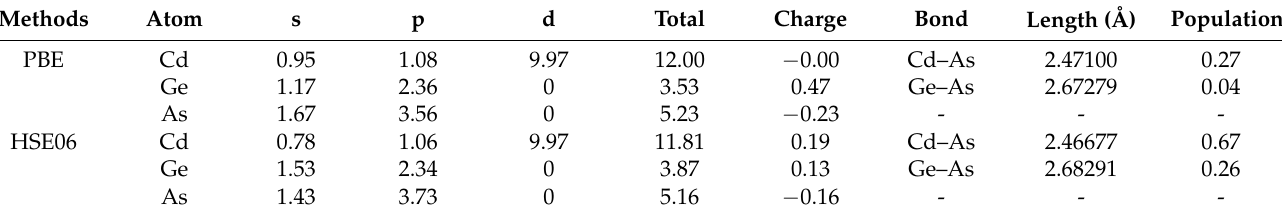
Table 4. The population analysis of CdGeAs 2.